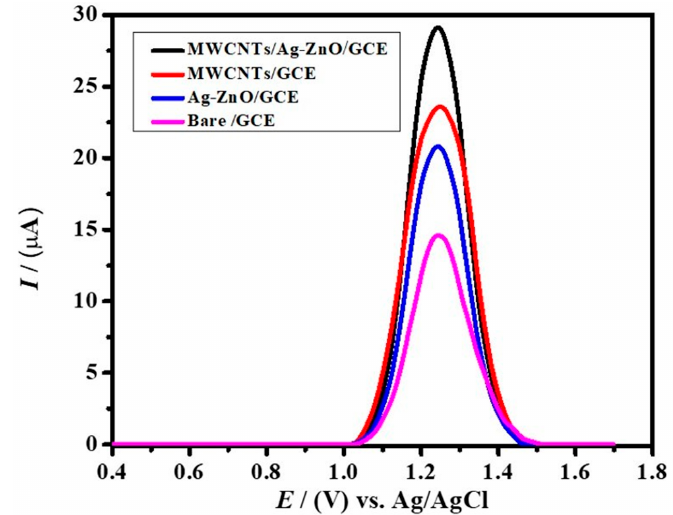
Figure 4. DPVs of 0.09 mM ibuprofen on bare GCE, Ag-ZnO/GCE, MWCNTS/GCE, and MWCNTs/Ag-ZnO/GCE in a supporting electrolyte of 0.9 M NaOH.